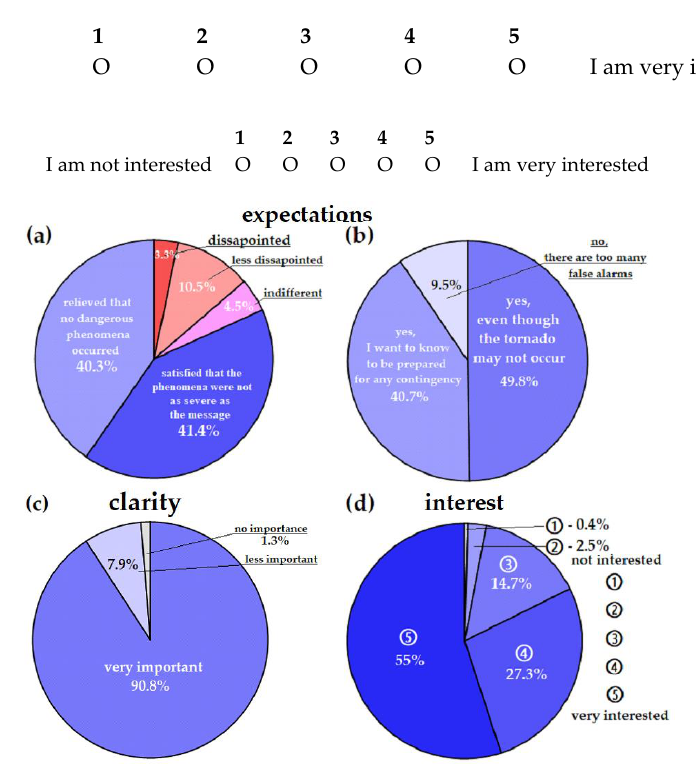
Figure A4. The summary of results from Q13 to Q16 regarding the expectations in cases of false alarms ( a ) and issuing messages although the probability of a tornado is low ( b ), how important is the word tornado to be clearly specified in a warning message ( c ), and the respondents’ interests in tornado as severe/extreme phenomenon ( d ). Q17. What is your age? *